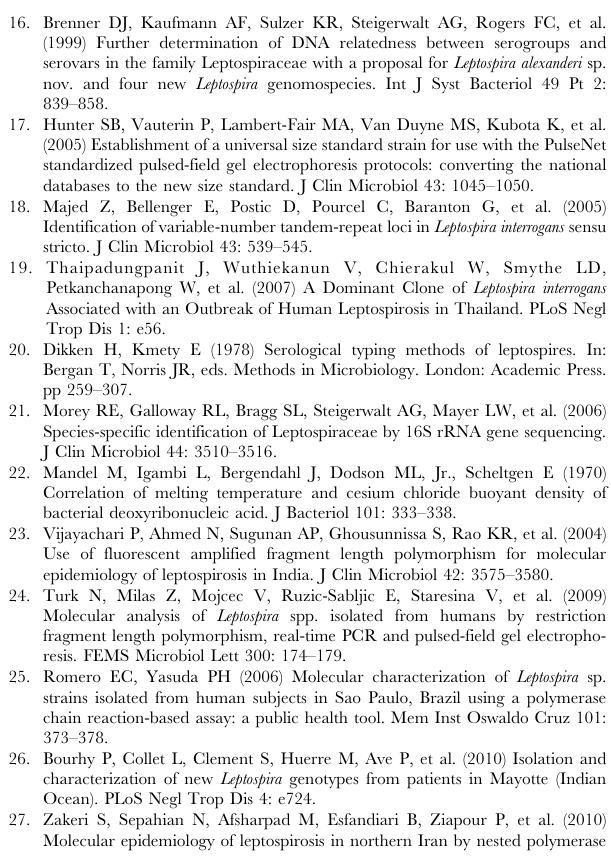
Figure S1 Dendrogram of PFGE patterns comparing all clinical isolates used in this